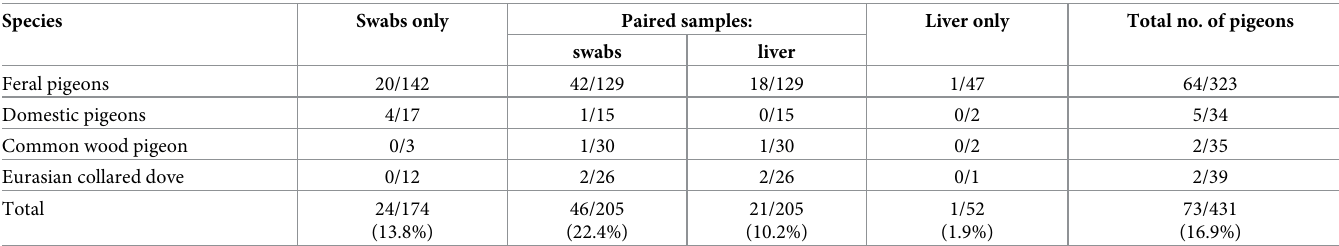
Table 3. Number of samples (positive/total) by pigeon species tested for Chlamydiaceae . Species Swabs only Paired samples: Liver only Total no. of pigeons swabs